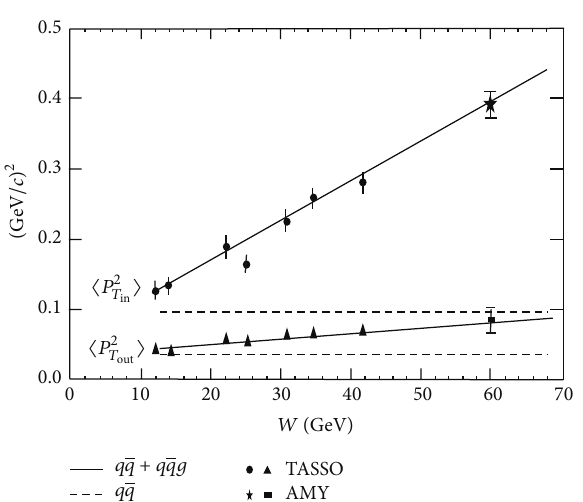
Figure 6: The average of the squared transverse momentum in the ⟩ , and perpendicular to the event plane, ⟨𝑃 2 event plane, ⟨𝑃 2 𝑇 in different c.m. energies [10].